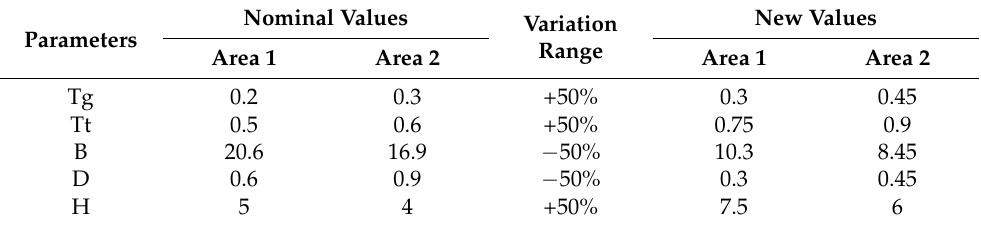
Table 21. The parameters of the testbed system under parametric